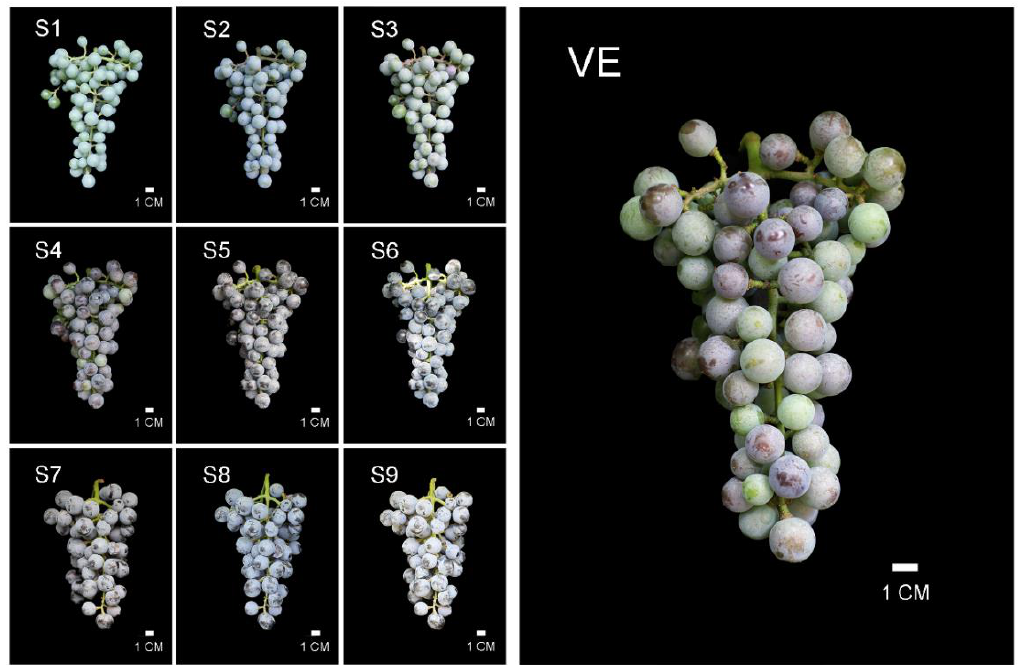
Figure 1. Photos of ‘Beimei’ were taken during sampling time in 2019. S1–S9 represent the sampling date in 2019, and bar = 1 cm.